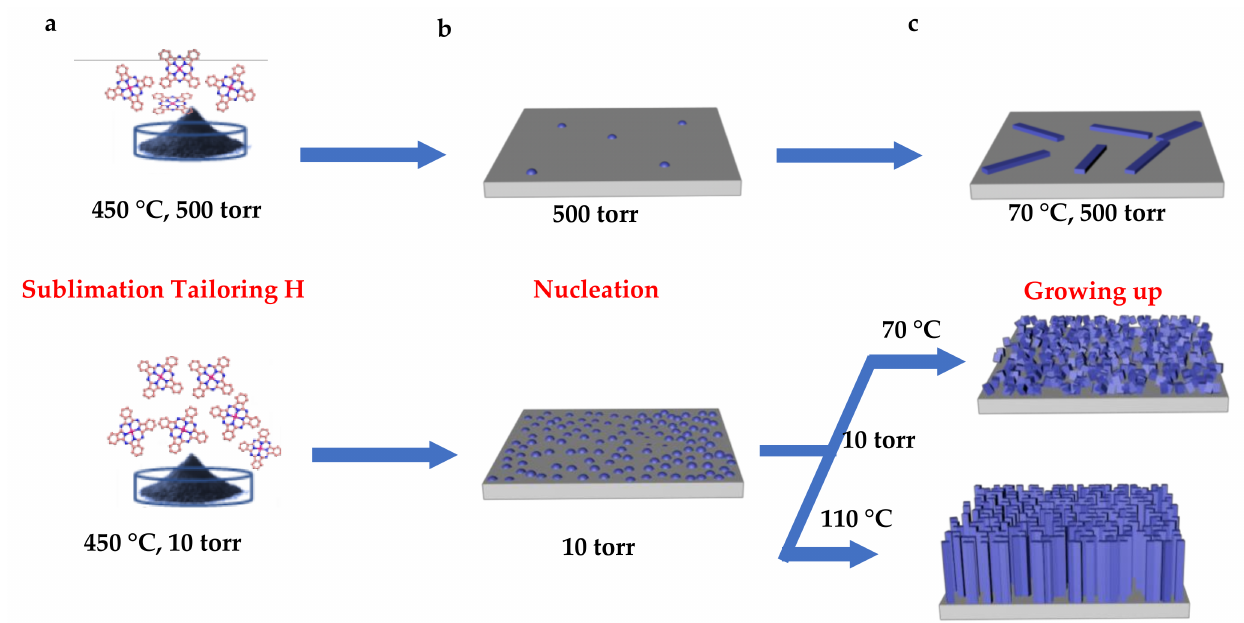
Figure 9. Schematic view of the forming process for the catalysts under different temperature and pressure conditions.